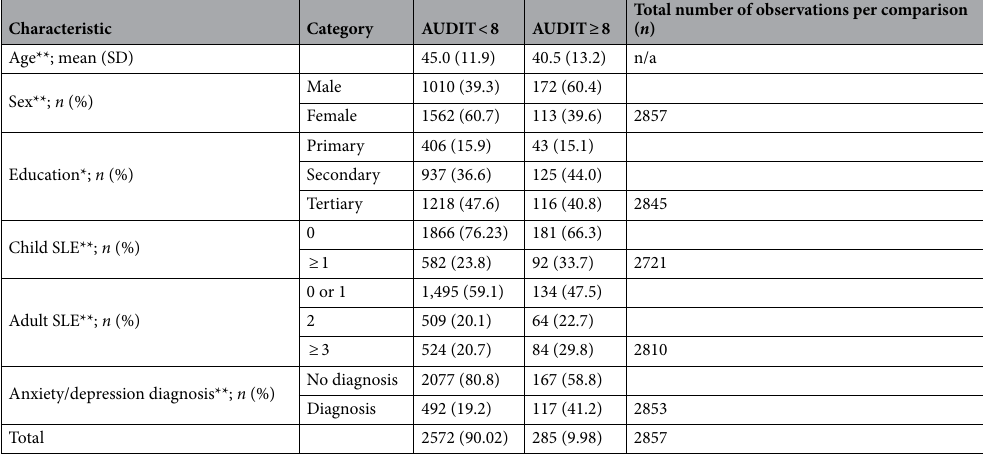
Table 1. Socio-demographic characteristics of the study population † and corresponding significance tests of between-group differences across AUDIT score categories. SLE Stressful life event; * p ≤ 0.05, ** p ≤ 0.01. † N = 58 observations had missing values for AUDIT score and were therefore excluded. In the comparison of AUDIT score across education categories, an additional 12 observations were excluded due to missing values for the education variable. Similarly, an additional N = 136 observations for child SLE, N = 47 observations for adult SLE, and N = 4 for diagnosis of anxiety or depression were excluded in the respective comparisons.